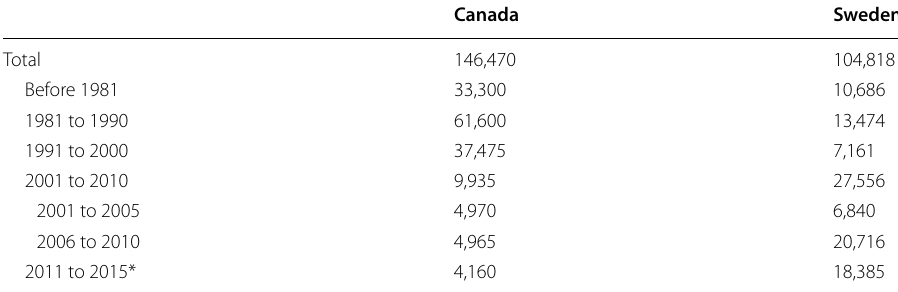
Source: Statistics Canada 2016 Census table: 98-400-X2016185 For Sweden the data is drawn from the Swedish register *For Canada the intake is 2011 to May 2016